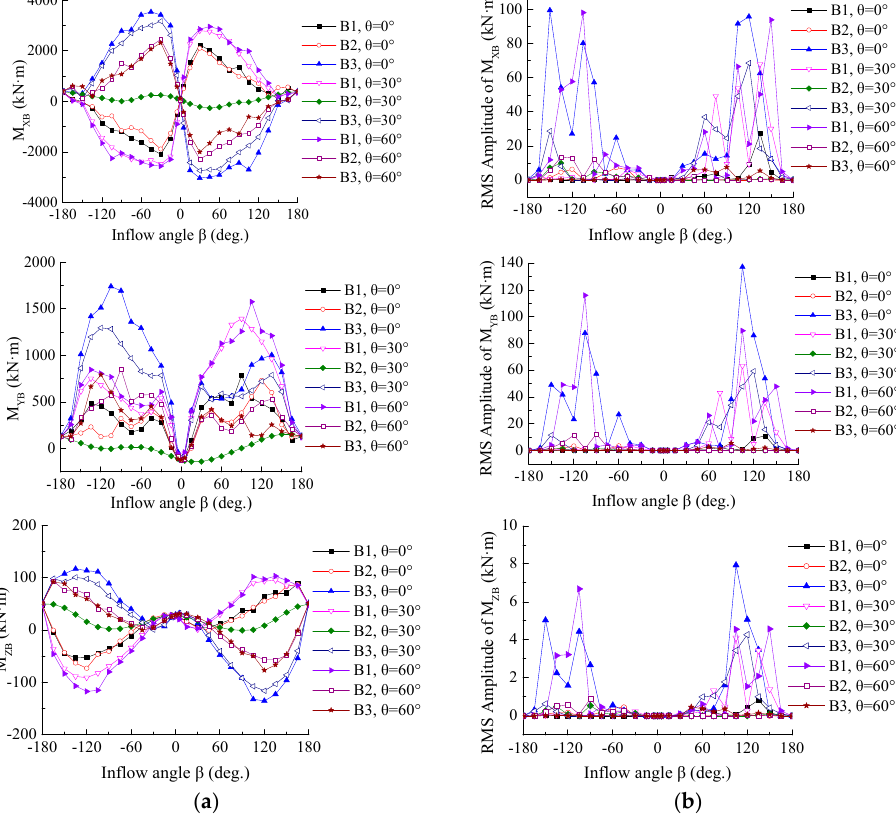
Figure 18. The blade root bending moments: ( a ) Average value; ( b ) RMS amplitude.